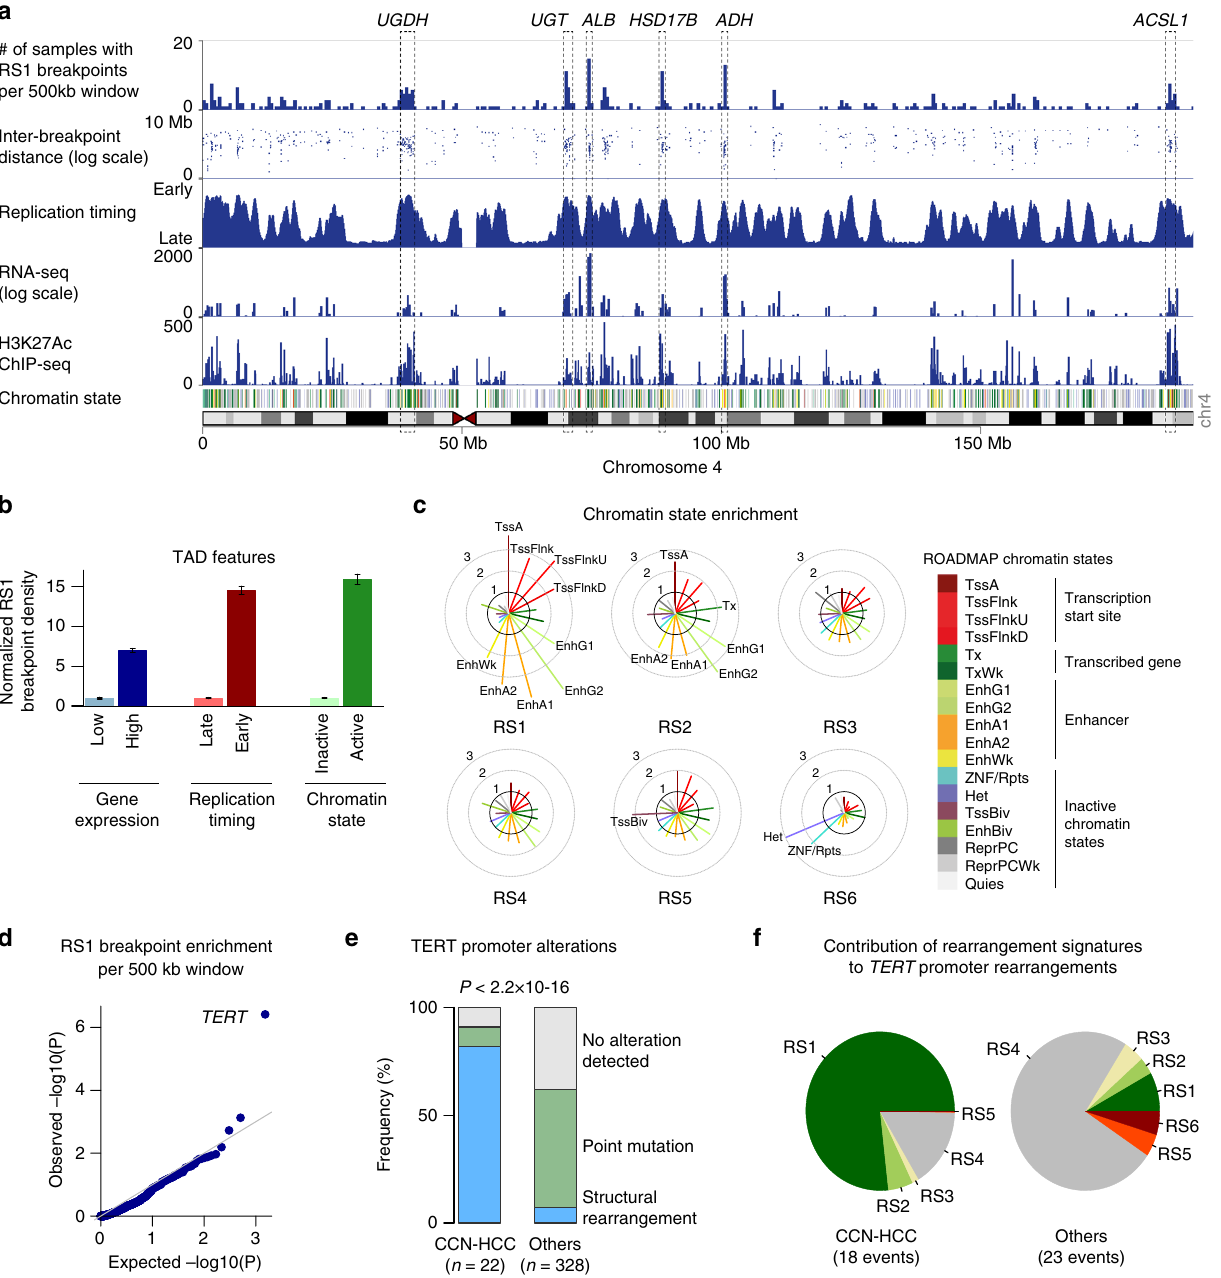
Fig. 5 Hotspot analysis of rearrangement signature 1 (RS1) breakpoints. a The density of RS1 breakpoints along chromosome 4 is displayed above replication timing, RNA-seq expression, H3K27Ac ChIP-seq pro fi le and chromatin state. Replication timing was determined using Repli-Seq data from the liver cancer cell line HepG2. RNA-seq pro fi le was generated from a normal liver sample. H3K27Ac and chromatin states in normal adult liver were obtained from the ROADMAP consortium. The legend for chromatin state color codes is displayed in c . Hotspots corresponding to highly expressed liver enzymes are annotated (UGDH, UDP-glucose 6-dehydrogenase; UGT, UDP glucuronosyltransferase family cluster; ALB, albumin; HSD17B, hydroxysteroid 17-Beta dehydrogenases 11 and 13, ADH, alcohol dehydrogenase cluster; ACSL1, acyl-CoA synthetase long chain family member 1). b RS1 breakpoint density in topologically associated domains (TADs). TADs were de fi ned in human embryonic stem cells (H1) and classi fi ed based on gene expression in normal liver, replication timing and chromatin state. For each comparison, breakpoint density was normalized to be 1 in the group with the lowest density. Error bars indicate the 95% con fi dence interval. c Enrichment of rearrangement breakpoints in ROADMAP chromatin states for the 6 rearrangement signatures identi fi ed in HCC. For each signature, the fold-change between the observed and expected number of breakpoints falling within each chromatin state is represented, and chromatin states with a >2-fold enrichment are annotated. d Quantile-quantile plot of RS1 breakpoint enrichment p-values across 500 kb windows. e Proportion of TERT promoter alterations in CCN-HCC and other HCC analyzed by WGS. f Contribution of the 6 rearrangement signatures to